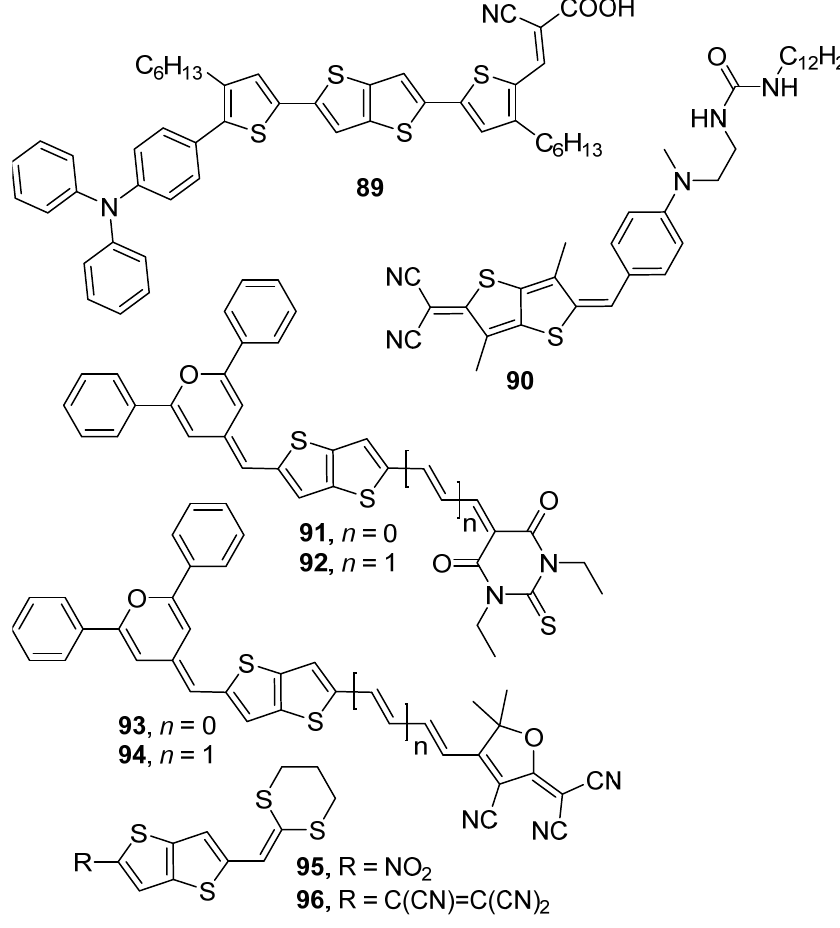
Figure 14. Push–pull TT derivatives 89 – 96 with NLO properties.